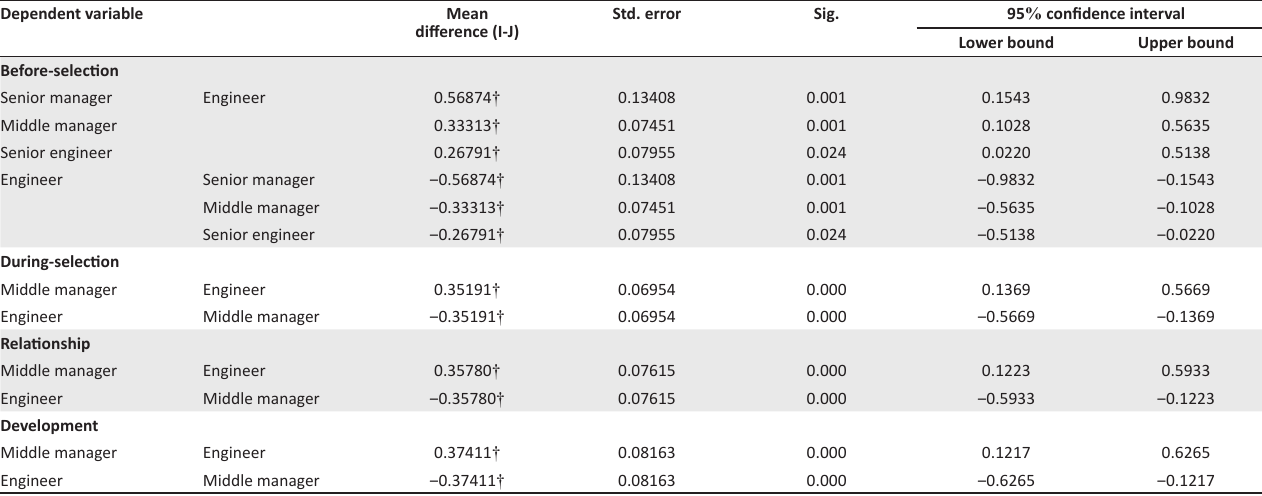
TABLE 7: Multi-comparison tests between managerial level groups.